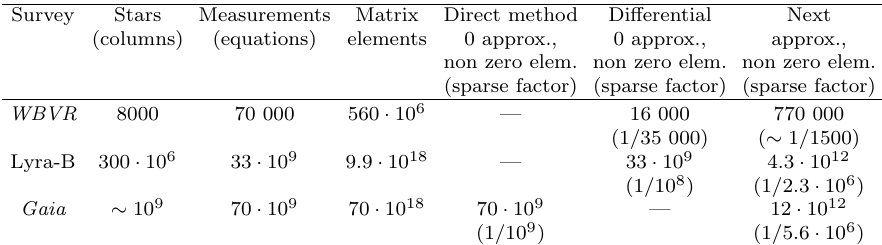
Table 1. Number of parameters in sparse design matrices for three surveys.